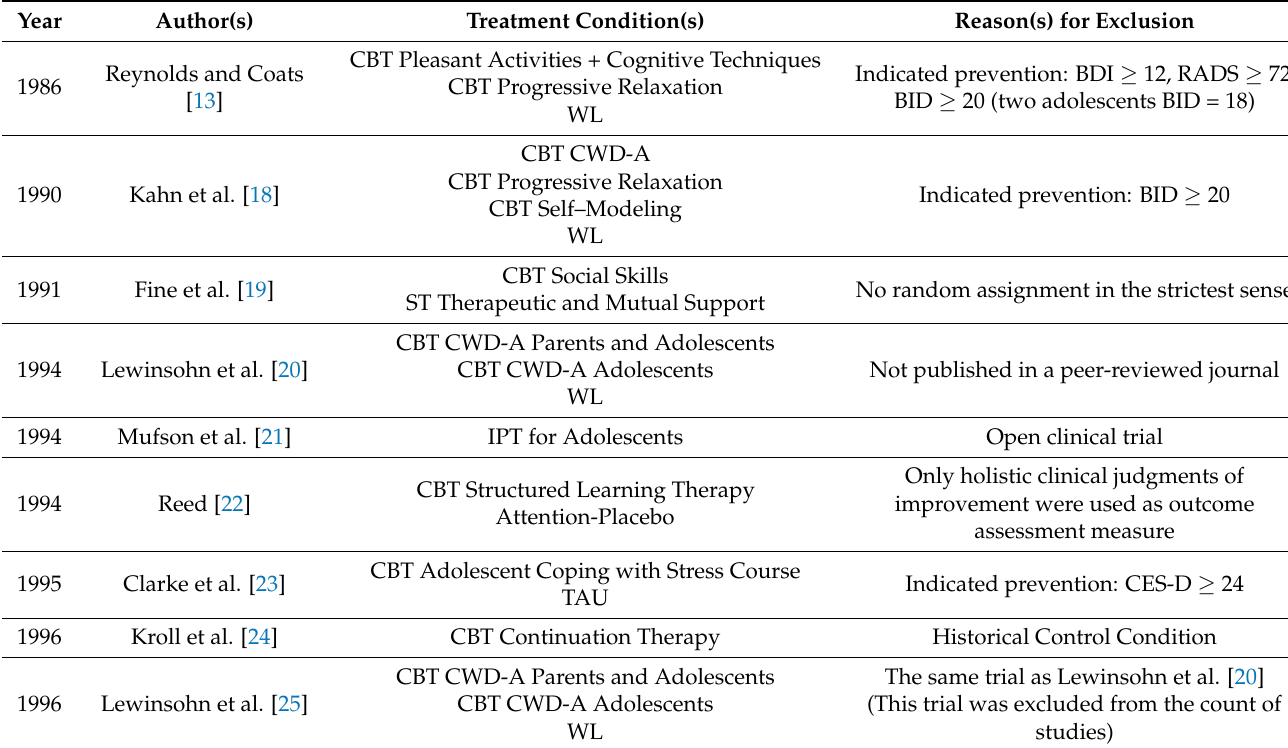
Table 2. Trials excluded from the current